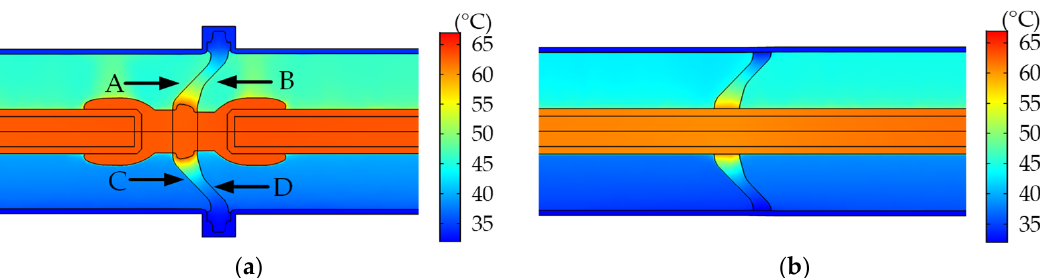
Figure 4. Temperature distribution with different geometry models. ( a ) represents the result of the real-type model, and ( b ) represents the result of the simplified model.